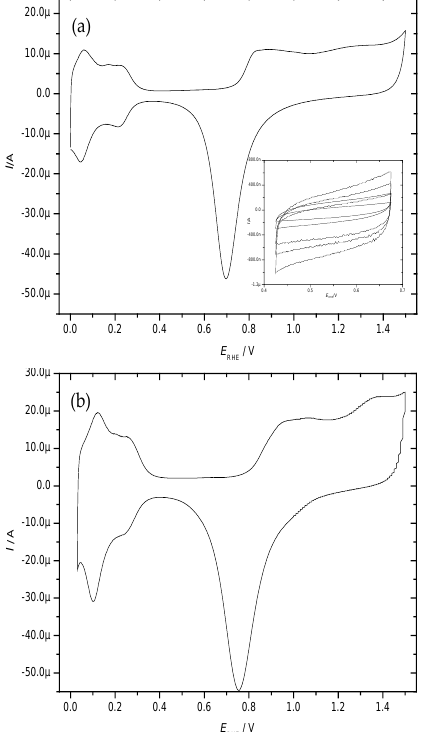
Figure 1. CVs of the platinum disc electrode: ( a ) top: polished; ( b ) bottom: with 21.44 mC platiniza- tion) in contact with an aqueous solution of 1 M HClO 4 (d E /d t = 0.1 V · s − 1 , solution deoxygenated with nitrogen). Insert top figure: CVs of the polished electrode in the double-layer region at various scan rates (d E /d t = 0.1 V · s − 1 ; 0.08; 0.06; 0.04; 0.02 V · s − 1 ) from outside in. For verification of the proper state of the platinum electrode surface in contact with the electrolyte solution containing the iron redox system, a typical CV is displayed in Figure 2.